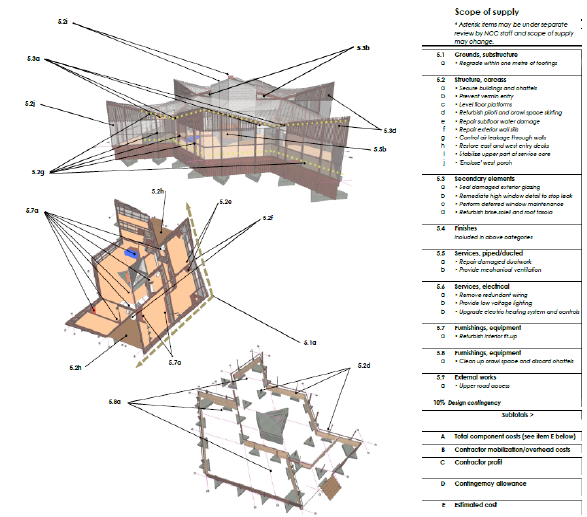
Figure 5. The HSR use of the building simulation model (©PTAH Consultants Inc.